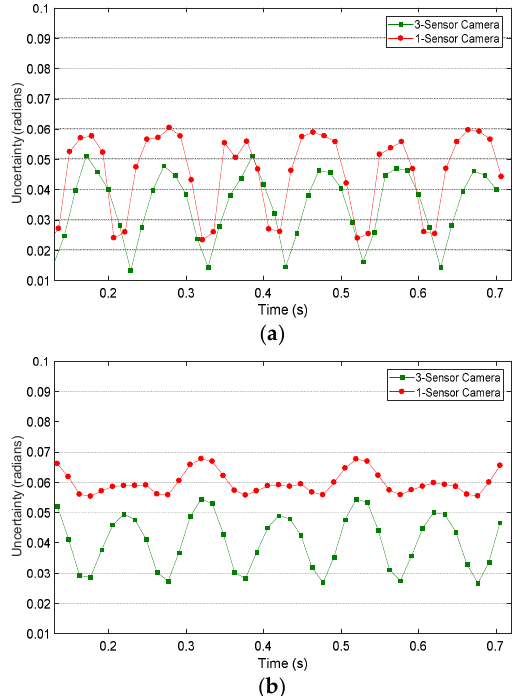
Figure 11. Standard deviation in Δ z displacement maps measured by 3-sensor camera (green) and 1-sensor camera (red) during vibration testing employing ( a ) an LCD projector and ( b ) a laser projector.